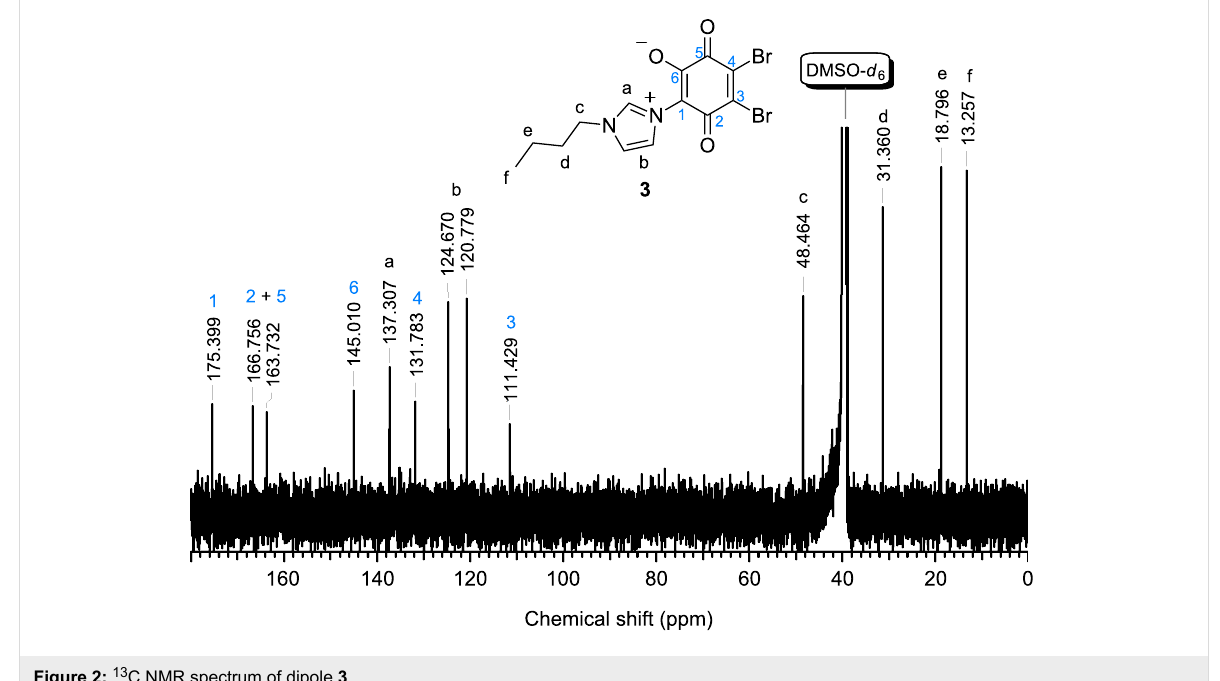
Figure 2: 13 C NMR spectrum of dipole 3 .